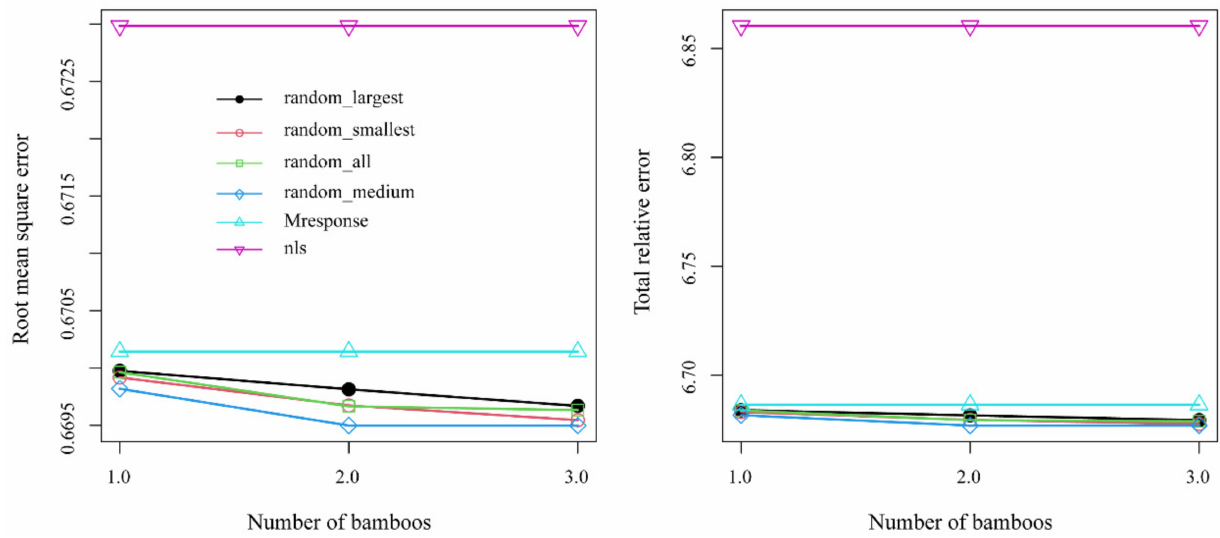
Figure 5. Performance of different selection strategies (root mean squared error (RMSE), total relative error (TRE), nonlinear ordinary least square (NLS; M6), mean response (M response) of M8, and M8 with four sampling strategies and DBH sample sizes per sample plot, for estimating the random effects (random: randomly selected DBH; largest: the largest DBH; medium: medium DBH; and smallest: the smallest